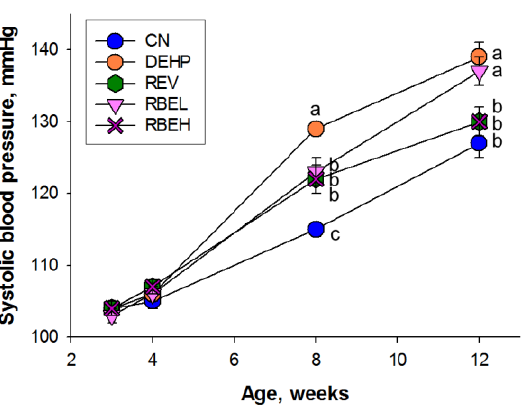
Figure 2. Effects of di-2-ethylhexylphthalate (DEHP), resveratrol (REV), and resveratrol butyrate ester (RBE) on systolic blood pressure in offspring from 3 to 12 weeks of age. The letters a, b and c indicate the differences between the groups ( p < 0.05, two-way ANOVA with post hoc Tukey’s test); N = 8/group.